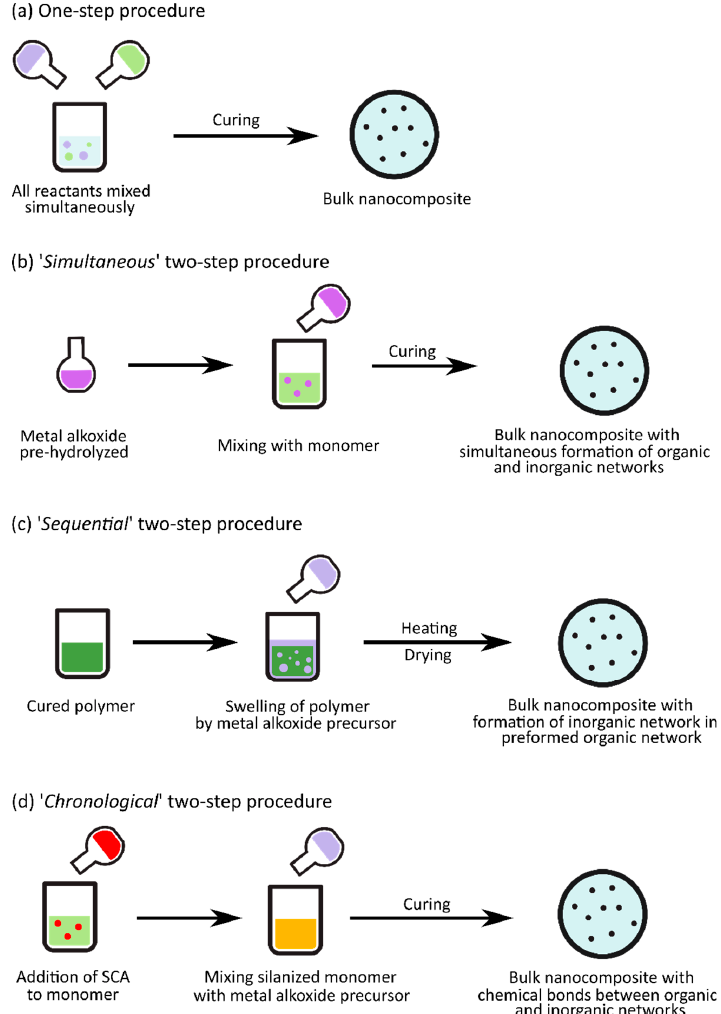
Figure 4. Schematic displaying the general principles of the ( a ) one-step procedure; and the ( b ) ‘s imultaneous ’; ( c ) ‘s equential ’; and ( d ) ‘c hronological ’ two-step procedures used in the in situ synthesis of epoxy nanocomposites. The colors of the various solutions are described as follow: The pure epoxy resins are indicated either by light green (monomer solution), dark green (polymer solution), or orange (monomers modified by silane coupling agents (SCA)), the inorganic oxide precursors are indicated by light purple, or dark purple (pre-hydrolyzed), and the SCAs are indicated by red.